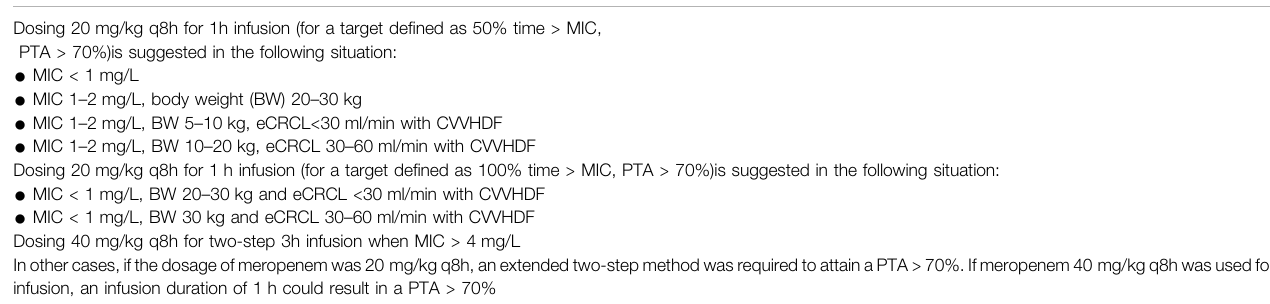
TABLE 7 | Dosing regimen